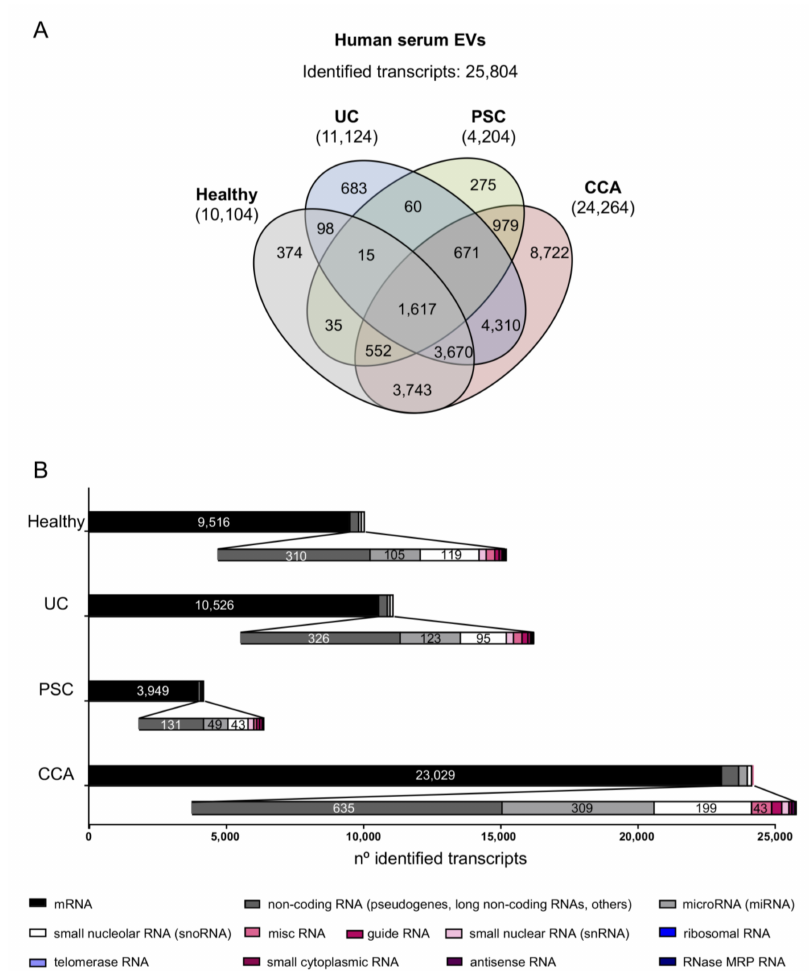
Figure 2. Comparative transcriptomic analysis of serum EVs from patients with CCA, PSC, or UC, and healthy individuals. ( A ) Venn diagrams showing the number of transcripts identified per group. Venn diagrams were generated using InteractiVenn web-based tool [29]. ( B ) Number of transcripts identified within each study group, subclassified according to their type [messenger RNA (mRNA), non-coding RNA (including mostly pseudogenes and long non-coding RNAs, among others), miscelaneous RNA (miscRNA), guide RNA, microRNA (miRNA), small nucleolar RNA (snoRNA), small nuclear RNA (snRNA), ribosomal RNA, telomerase RNA, small cytoplasmic RNA, antisense RNA and RNase MRP RNA]. In all groups, mRNAs constitute the most abundantly identified RNAs, followed by non-coding RNAs (pseudogenes, lncRNAs, and others), miRNAs, and